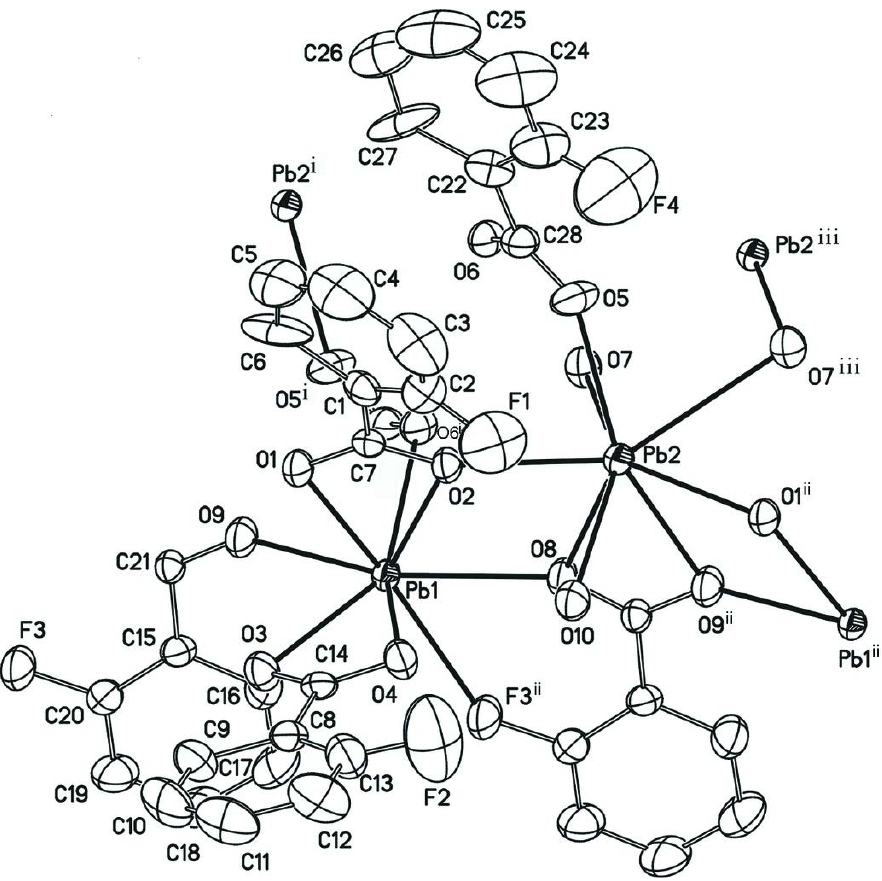
Figure 1 The asymmetric unit of the title compound, together with symmetry-related atoms to complete the coordination units. Displacement ellipsoids are drawn at the 35% probability level. H atoms have been omitted for clarity. [Symmetry codes: (i) 1 - x , - y , - z ; (ii) 1 + x , y , z ; (iii) 2 - x , - y , - z